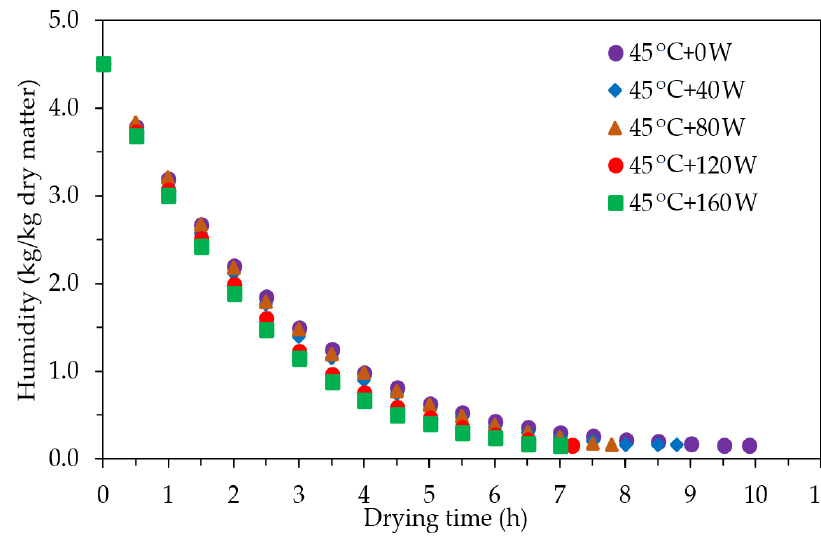
Figure 6. Drying curves at 45 °C with different ultrasonic power levels.